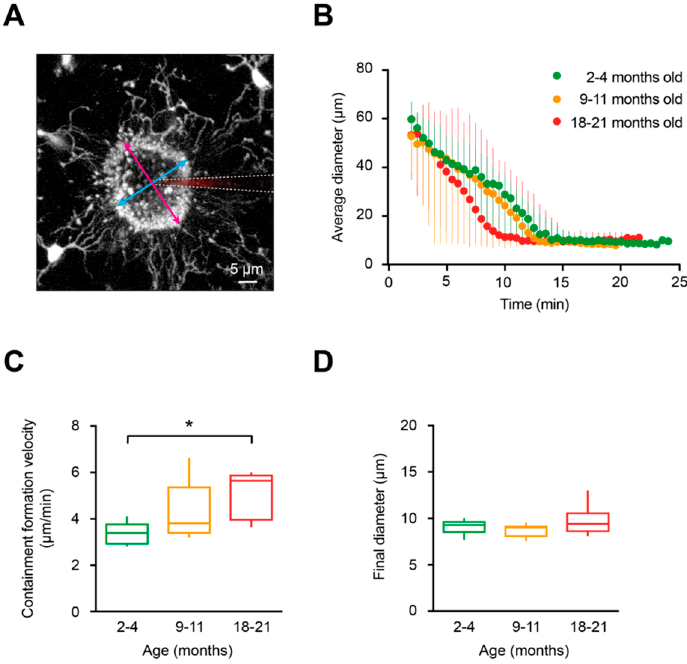
Figure 4. Characterization of the containment formation around the ATP-containing pipette. ( A ) MIP image of a Z stack (80–100 µ m below the cortical surface, 2 µ m step size), exemplifying the containment formation in a 2-month-old mouse. The stack is taken 7 min after pressure application (50 ms, 30 kPa) of 5 mM ATP. Magenta and cyan arrows indicate the major and minor diameters of the containment, respectively. White dashed lines emphasize the location of the ATP-containing pipette. ( B ) Graph illustrating changes in the average diameter of the containment over time in 2–4- (green), 9–11- (orange) and 18–21- (red) month-old mice. The moment of the ATP application is taken as time point 0. ( C ) Box-and-whisker plot illustrating median (per mouse) containment formation velocity in 2–4- (green), 9–11- (orange) and 18–21- (red) month-old mice. The containment formation velocity in 18–21-month-old mice was significantly faster than in 2–4-month-old mice ( p = 0.04 for 2-4- vs.18–21-month-old mice, p = 0.55 for 2–4- vs. 9–11-month-old mice and p = 0.86 for 9–11- vs. 18–21-month-old mice, Kruskal–Wallis test; n = 5, 5, 6 mice for 2–4-, 9–11-, and 18–21-month-old mice, respectively). ( D ) Box-and-whisker plot illustrating the final diameter of the containment formed by the microglial processes around the pipette in 2–4- (green), 9–11- (orange) and 18–21- (red) month-old mice. The final diameters of the containment around the pipette tip were similar among the three age groups ( p = 0.17, Kruskal–Wallis test; n = 5, 5, 6 mice for 2–4-, 9–11-, and 18–21-month-old mice, respectively). * p < 0.05 in ( C ).